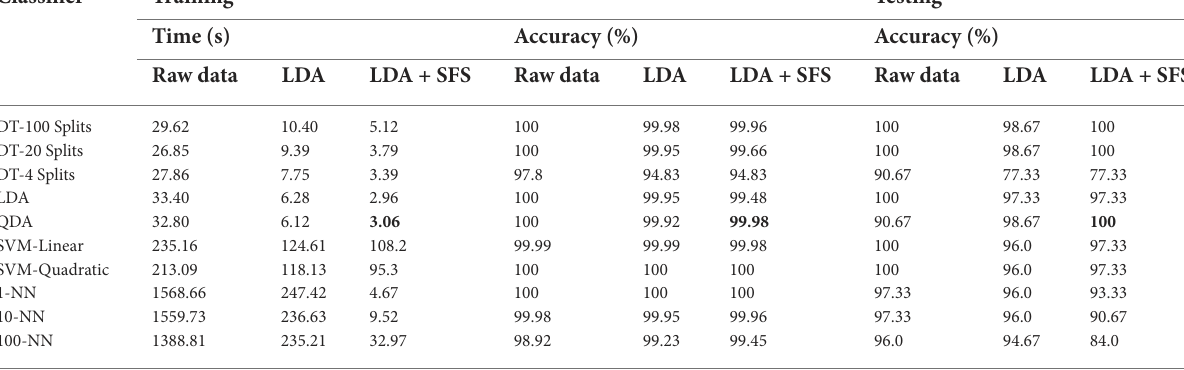
TABLE 2 Comparativestudy,evaluatingthespeedandaccuracyofmultipleclassificationtechniqueswithdifferentdimensionalityreductiontechniques using80%ofthedata(322events)fortrainingand20%ofthedata(75events)fortesting. Classifier Training Testing Time (s) Accuracy (%) Accuracy (%) Raw data Raw